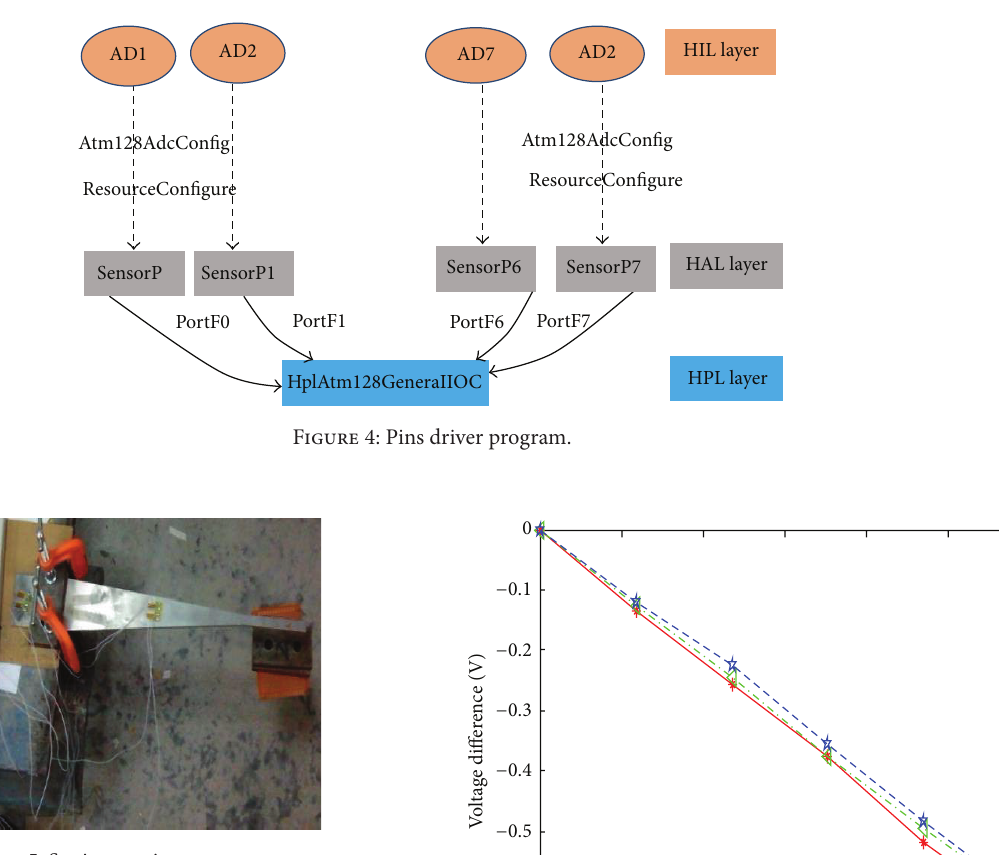
Figure 5: Static experiment setup.